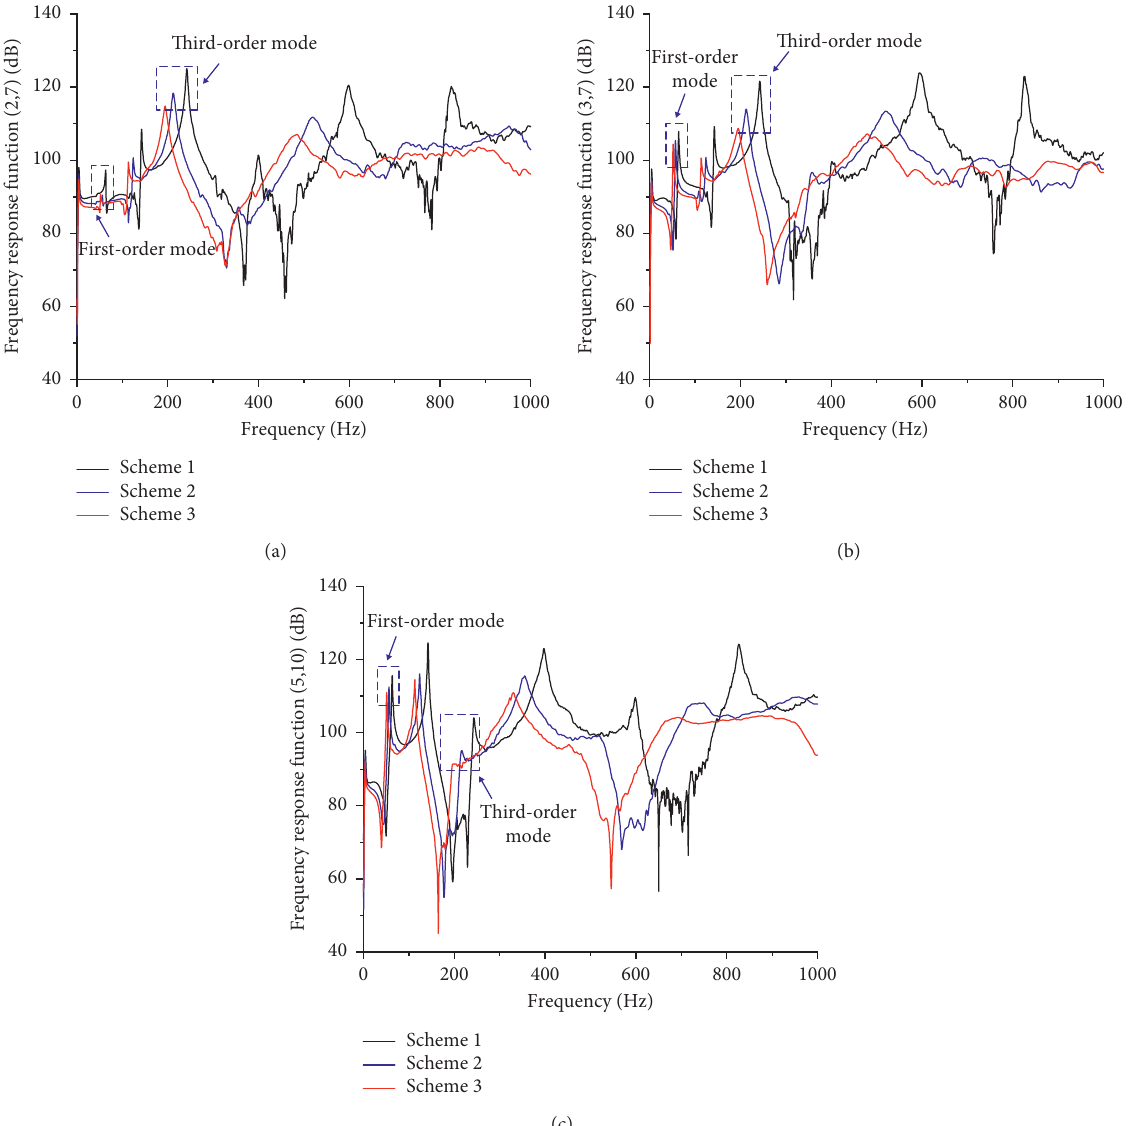
Figure 15: Frequency response functions at different damping parameters in trapezoidal cross section: excitation response at points (a) (2, 7), (b) (3, 7), and (c) (5, 10).